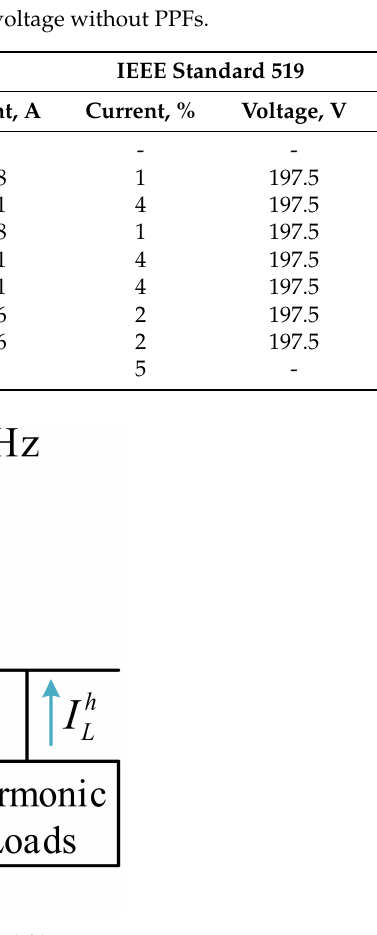
Figure 6. One-line diagram with two single-tuned